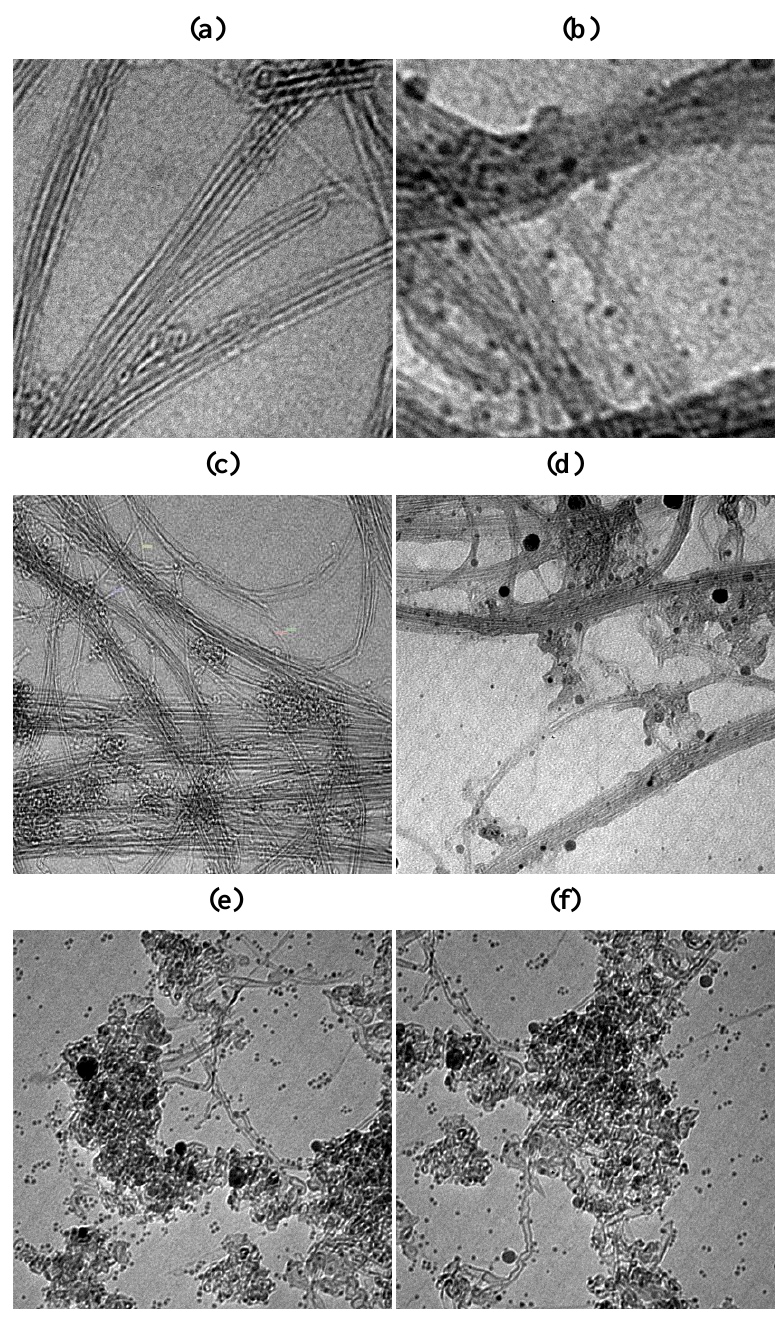
Figure 4. (a) 200 kX TEM of SWNTs in the as-purchased state; (b) 200 kX TEM of PSS-SWNTs (polystyrene sulfonate single-walled carbon nanotubes) without ultrasonication; (c) 63 kX TEM of SWNTs in the as-purchased state; (d) 63 kX TEM of PSS-SWNTs without ultrasonication; ( e) 63 kX TEM of PSS-SWNTs after 20 hours of ultrasonication; ( f) 63 kX TEM of PSS-SWNTs after 20 hours of